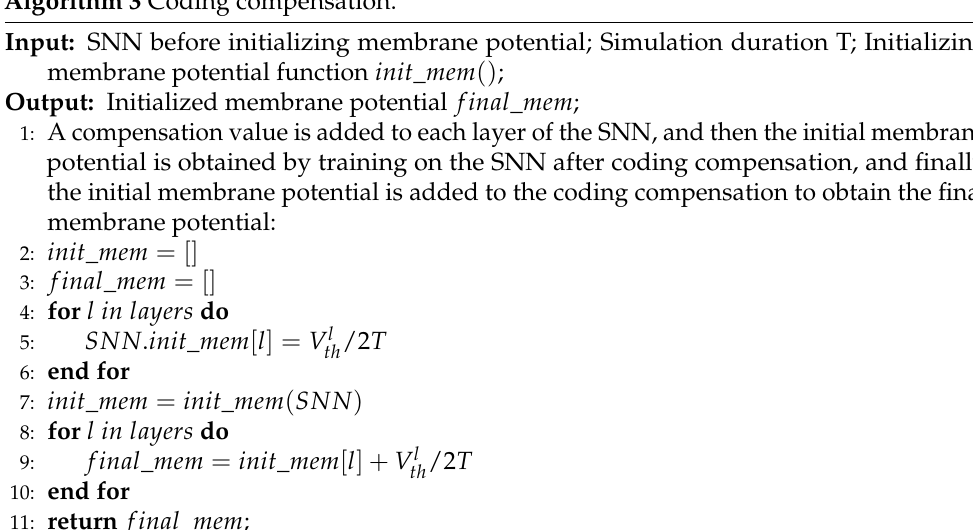
Algorithm 3 Coding